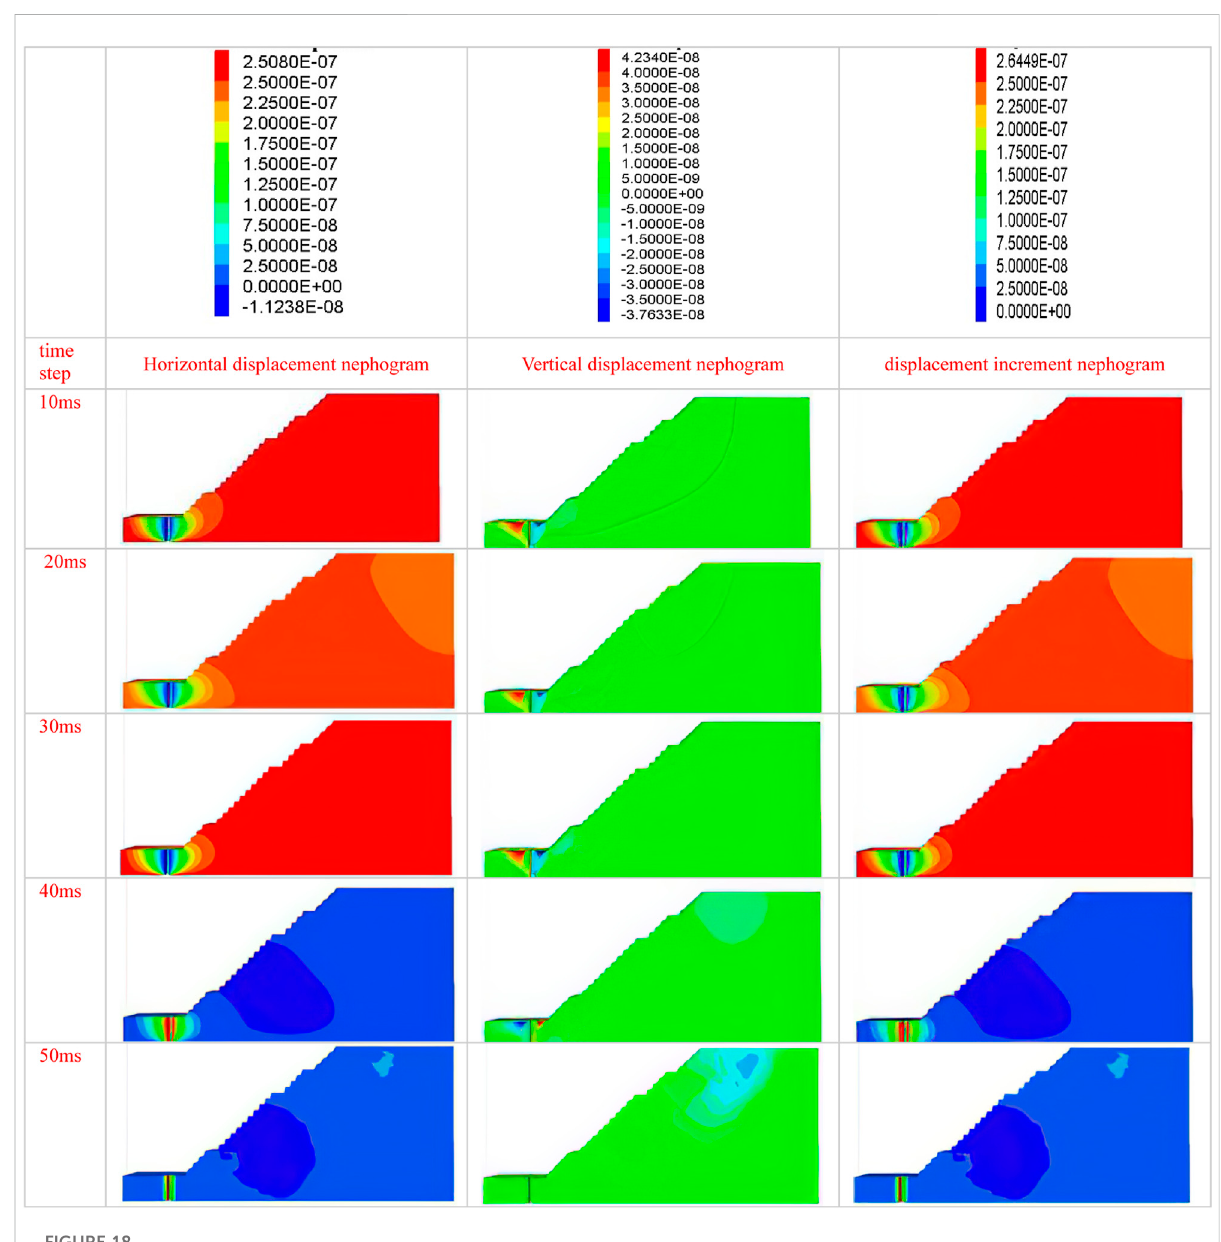
FIGURE 18 Horizontal displacement, vertical displacement, and displacement incremental cloud map